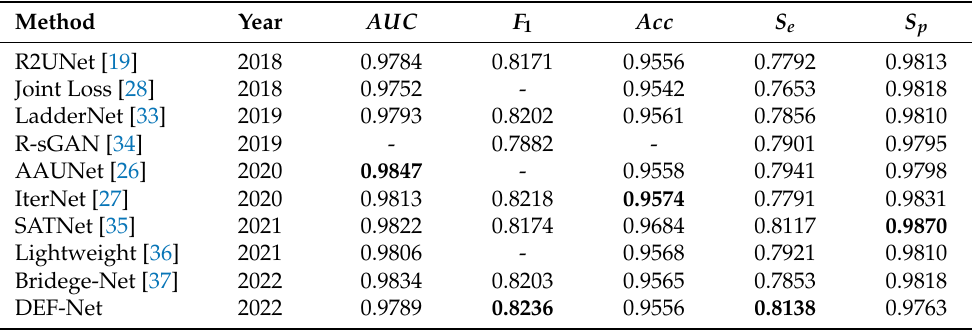
Table 4. Comparison results with advanced methods on DRIVE